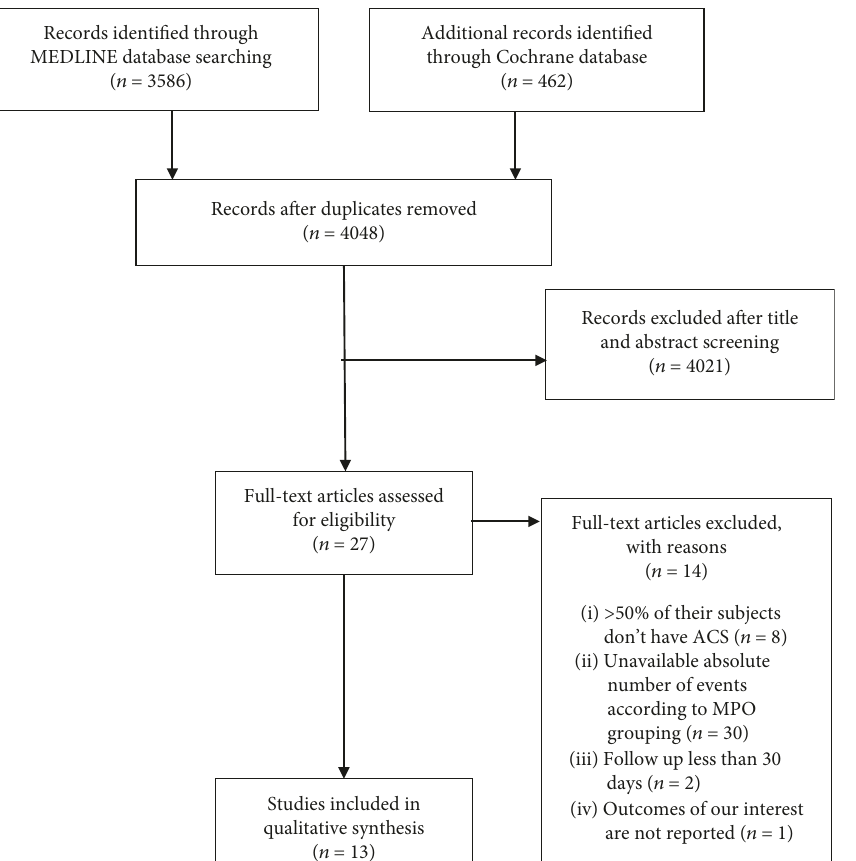
Figure 1: Flow chart of search